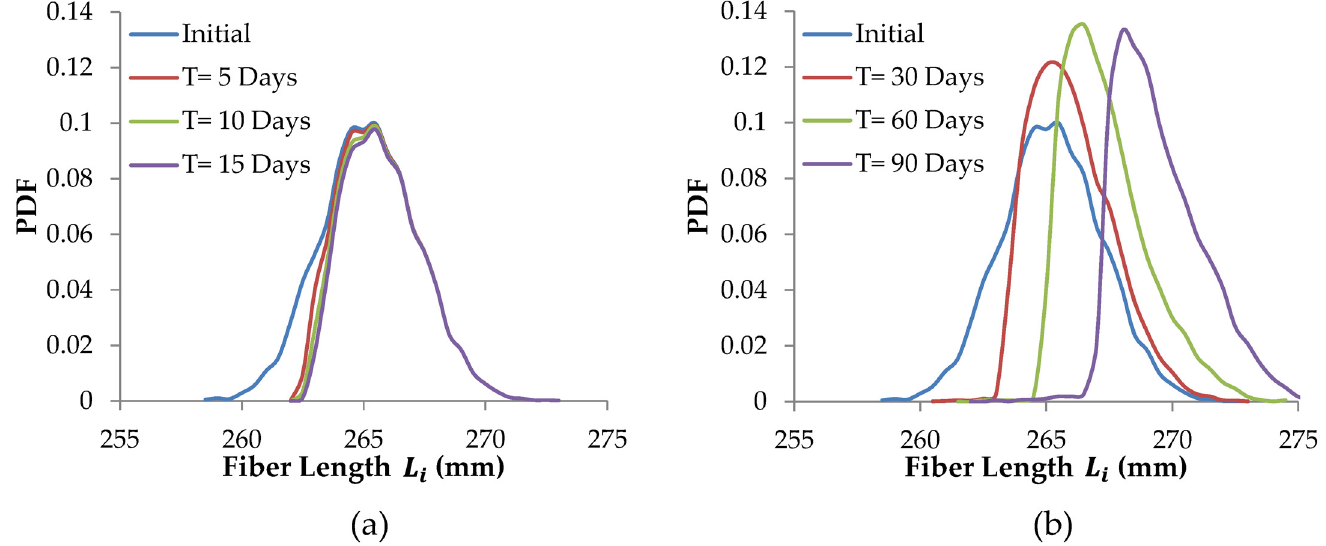
Fig 8. Tendon remodeling by mechanical damage and repair. a) tendon remodeling by mechanical damage alone over 15 days, b) tendon remodeling by mechanical damage and repair over 90 days. Tendon peak force and number of loading cycles are kept constant for all simulated days.